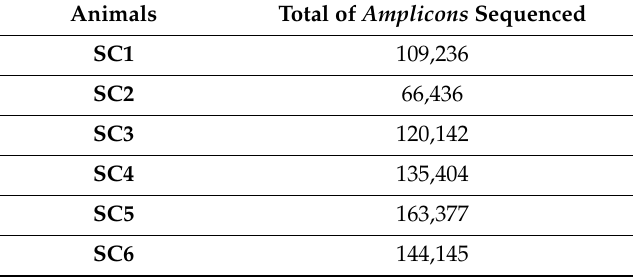
Table A1. Number of amplicons obtained after sequencing and preprocessing the ITS1 region of SC and CC